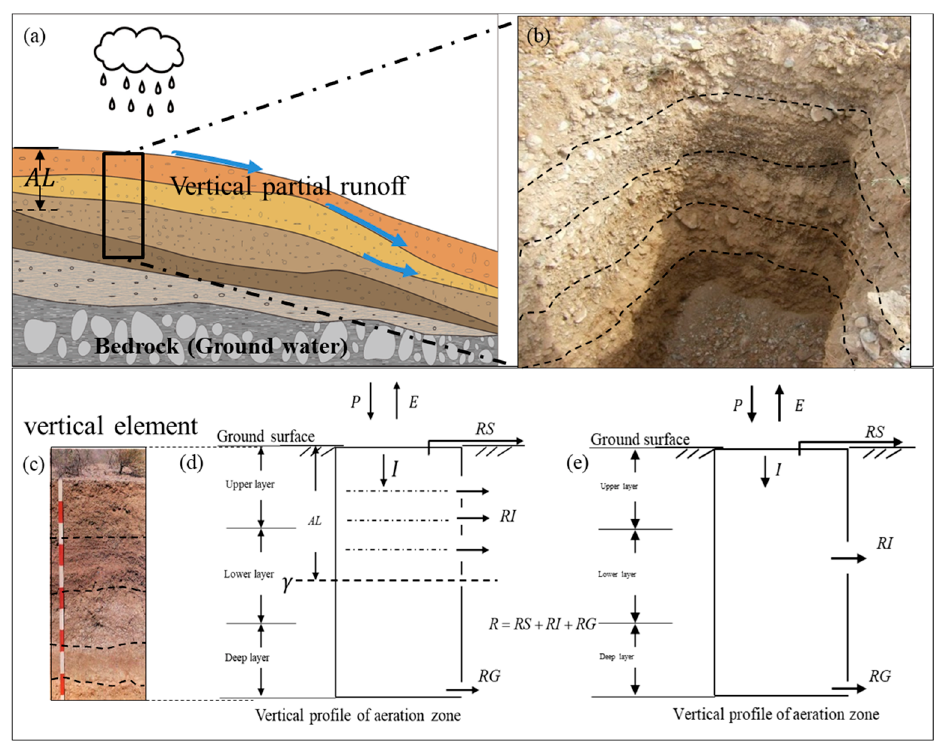
Figure 1. The generalization of runoff generation process in ( a ) and ( b ) for a hillside and ( c )–( e ) for a vertical element of soil.